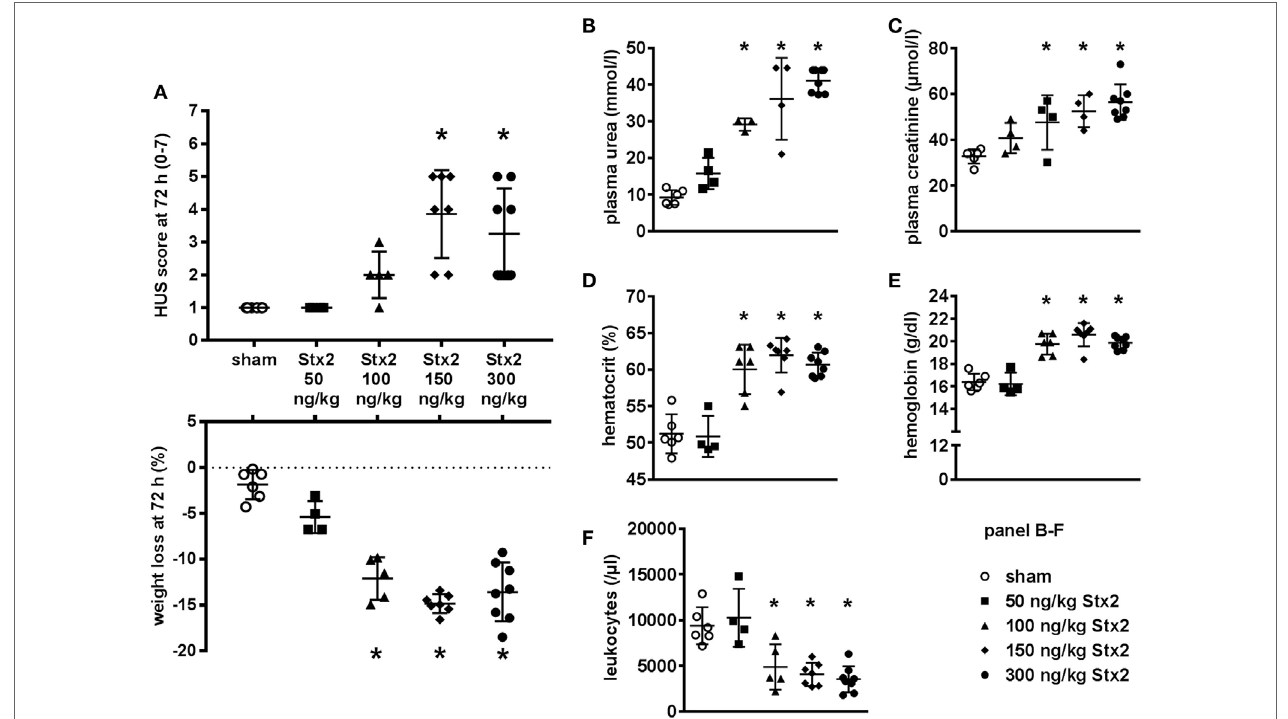
FigUre 1 | Dose-response study for Stx2 in C57BL/6J mice. (a–F) Mice were subjected to different Stx2 concentrations. The effect was assessed after 72 h. Data are expressed as mean ± SD for n observations, * p < 0.05 vs. sham. (a) Final score and overall weight loss at 72 h (score: Kruskal–Wallis test with Dunn’s correction, weight loss: one-way ANOVA with Bonferroni post hoc test; sham n = 6, 50 ng/kg BW Stx2 n = 4, 100 ng/kg BW Stx2 n = 5, 150 ng/kg BW Stx2 n = 7, 300 ng/kg BW Stx2 n = 8). Kidney function was evaluated by (B) plasma urea and (c) plasma creatinine. (D) Hematocrit and (e) hemoglobin were measured as indicators of red blood cell count. Immune response was monitored by (F) white blood cell count. (B–F) Groups: sham n = 6, 50 ng/kg Stx2 n = 4, 100 ng/kg Stx2 n = 6, 150 ng/kg Stx2 n = 7, 300 ng/kg Stx2 n = 8 (one-way ANOVA with Bonferroni post hoc